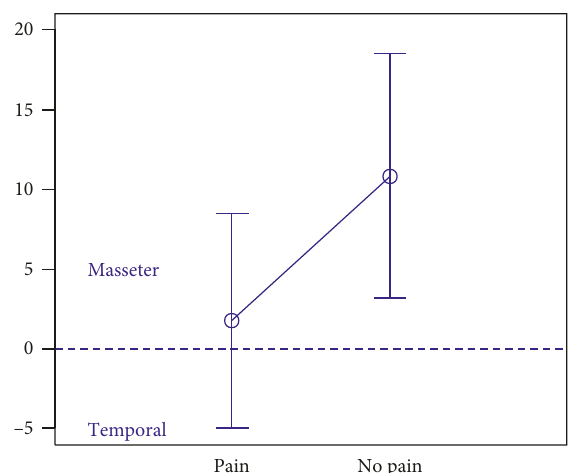
Figure 6: Activity index during maximum clenching in group of individuals with depression.